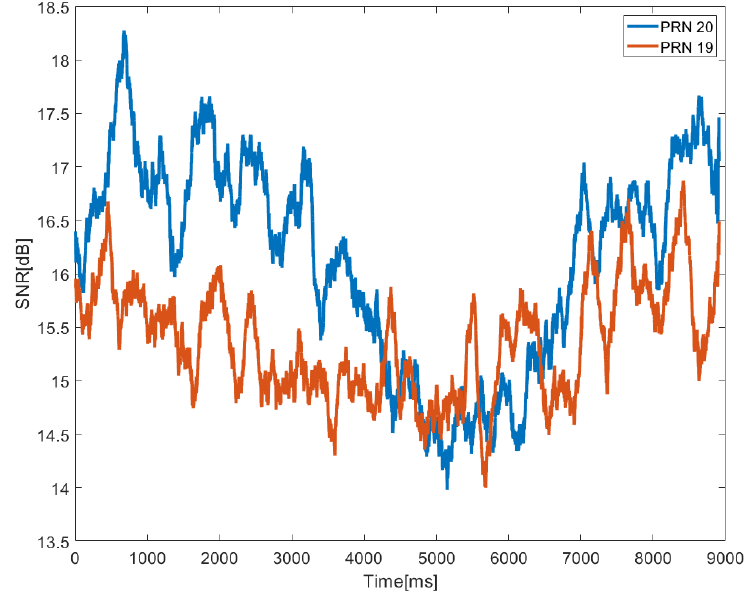
Figure 10. SNR evaluation for PRN20 and PRN 19, obtained during a test using real